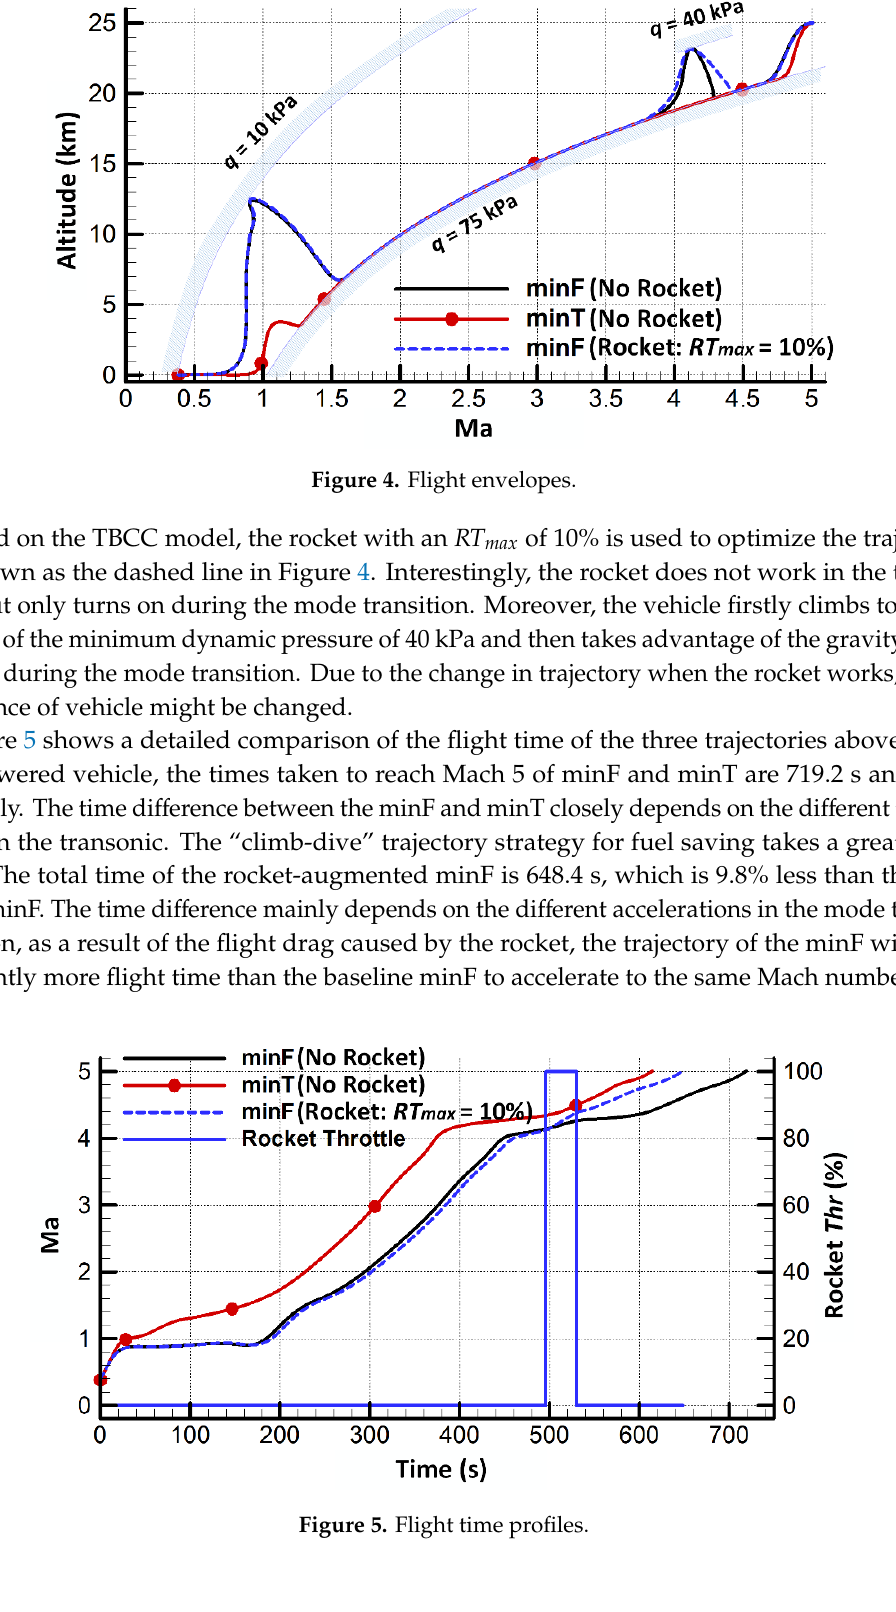
Figure 5. Flight time profiles.